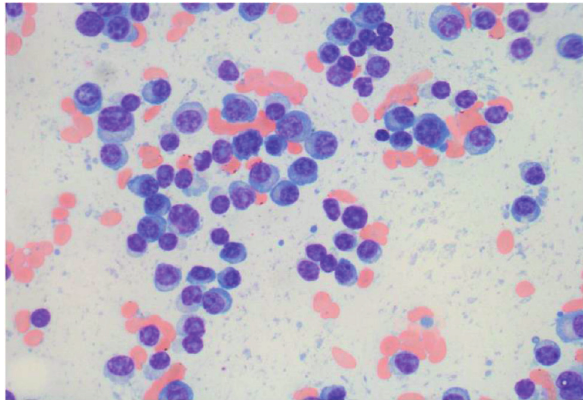
Figure 2: Plasma cells in bone marrow aspirate smear.